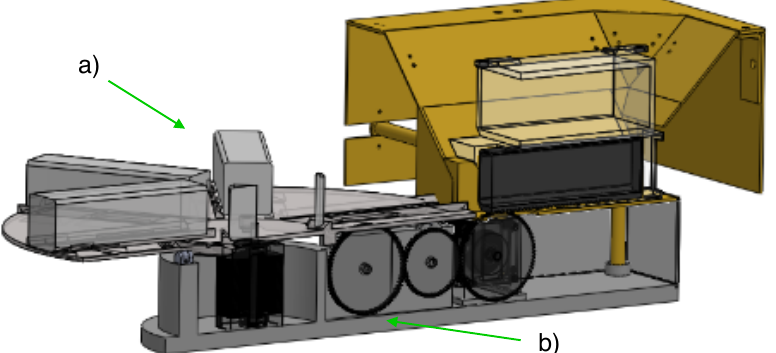
Figure 4. Battery storage design for UAV ground station: ( a ) circular battery array, and ( b ) mechanic base.